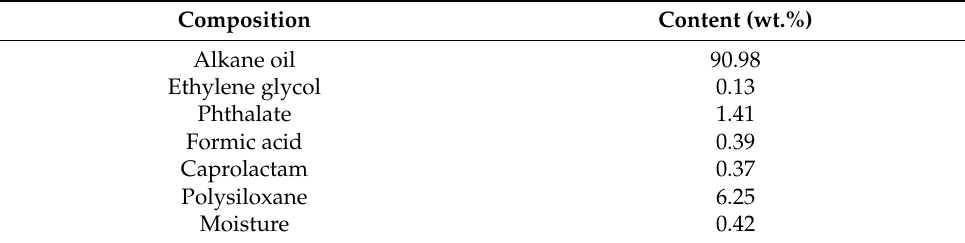
Table 2. Composition analysis of